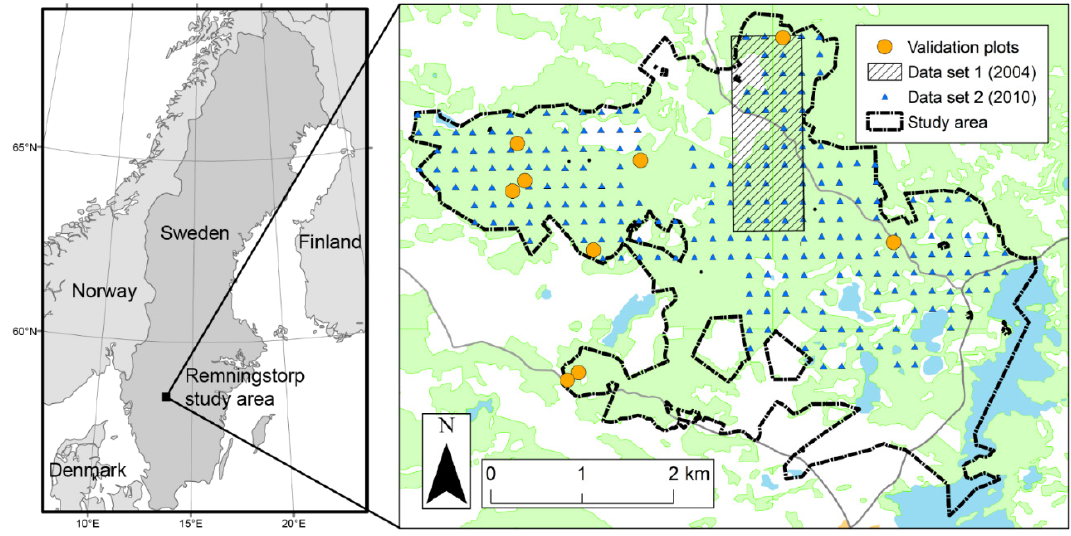
Figure 2. Overview of the study area, the location of the field inventoried training plots, and the validation plots used for assimilation. Data set 1 consists of 849 field plots located in a regular grid of 40 m within the cross-hatched area. © Lantmäteriet I2014/00764.